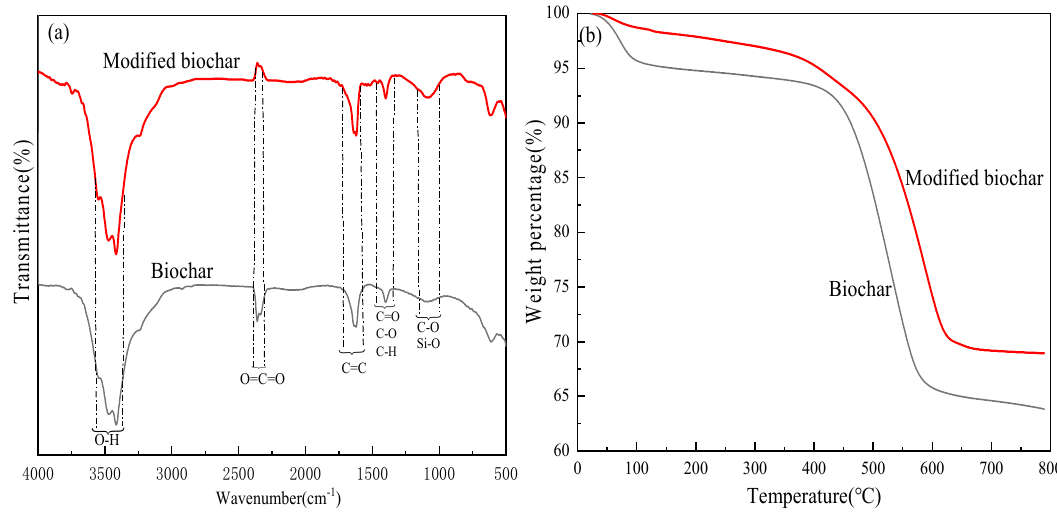
Figure 6. ( a ) Fourier transform infrared spectroscopy spectra and ( b ) thermogravimetric curves of biochar before and after modification.